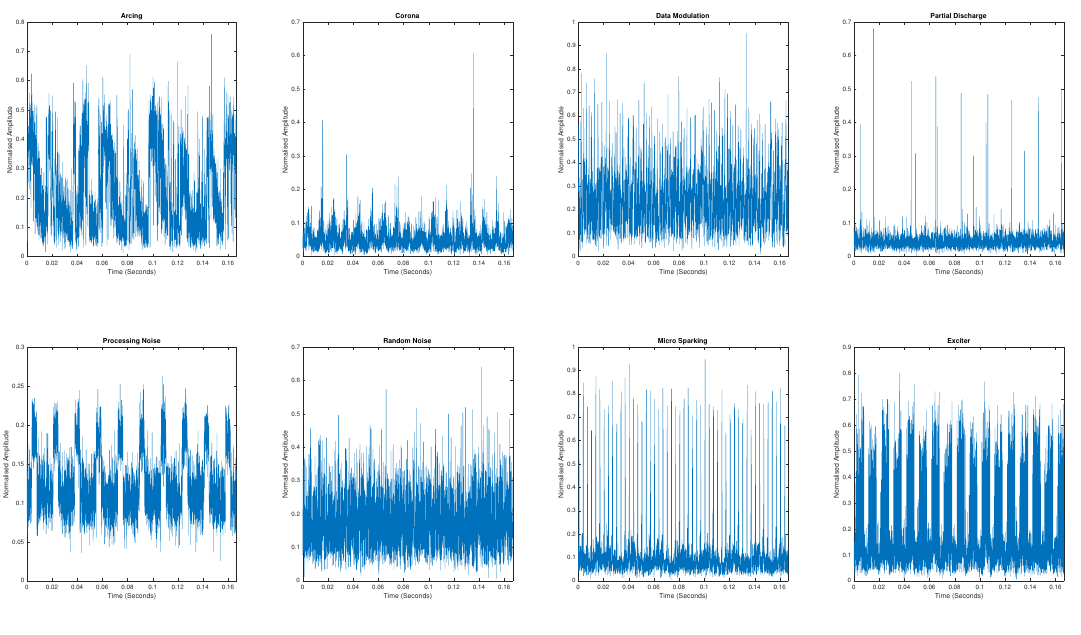
Figure 8. Raw time-series EMI fault signals, representing each prevalent